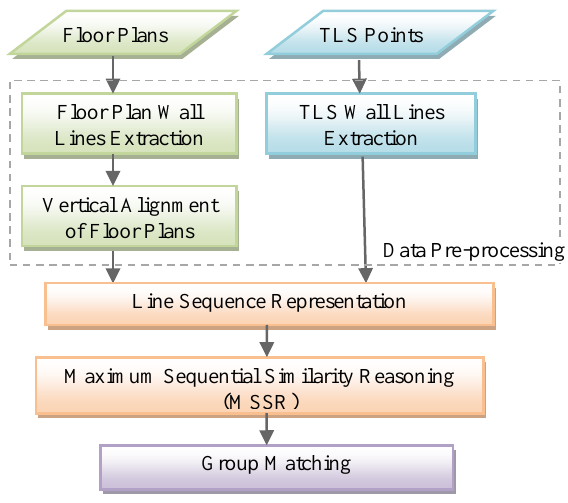
Figure 2. A photo, original TLS point clouds and floor plan of the test building